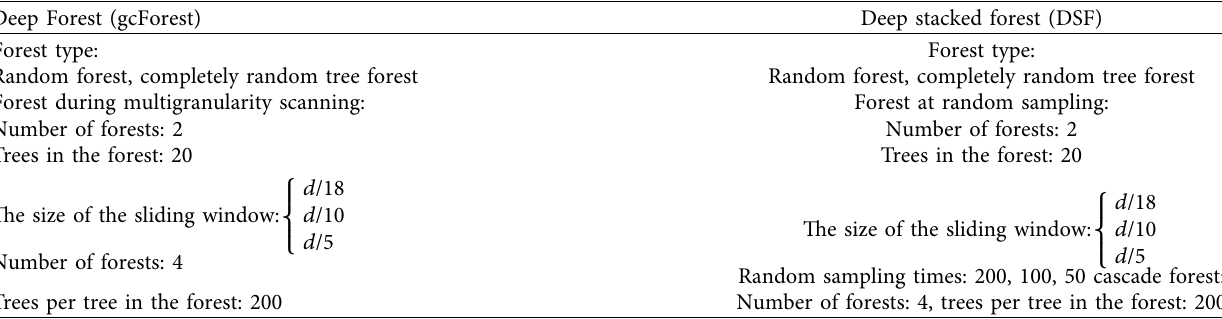
Table 3: Hyperparameter settings of gcForest and DSF.